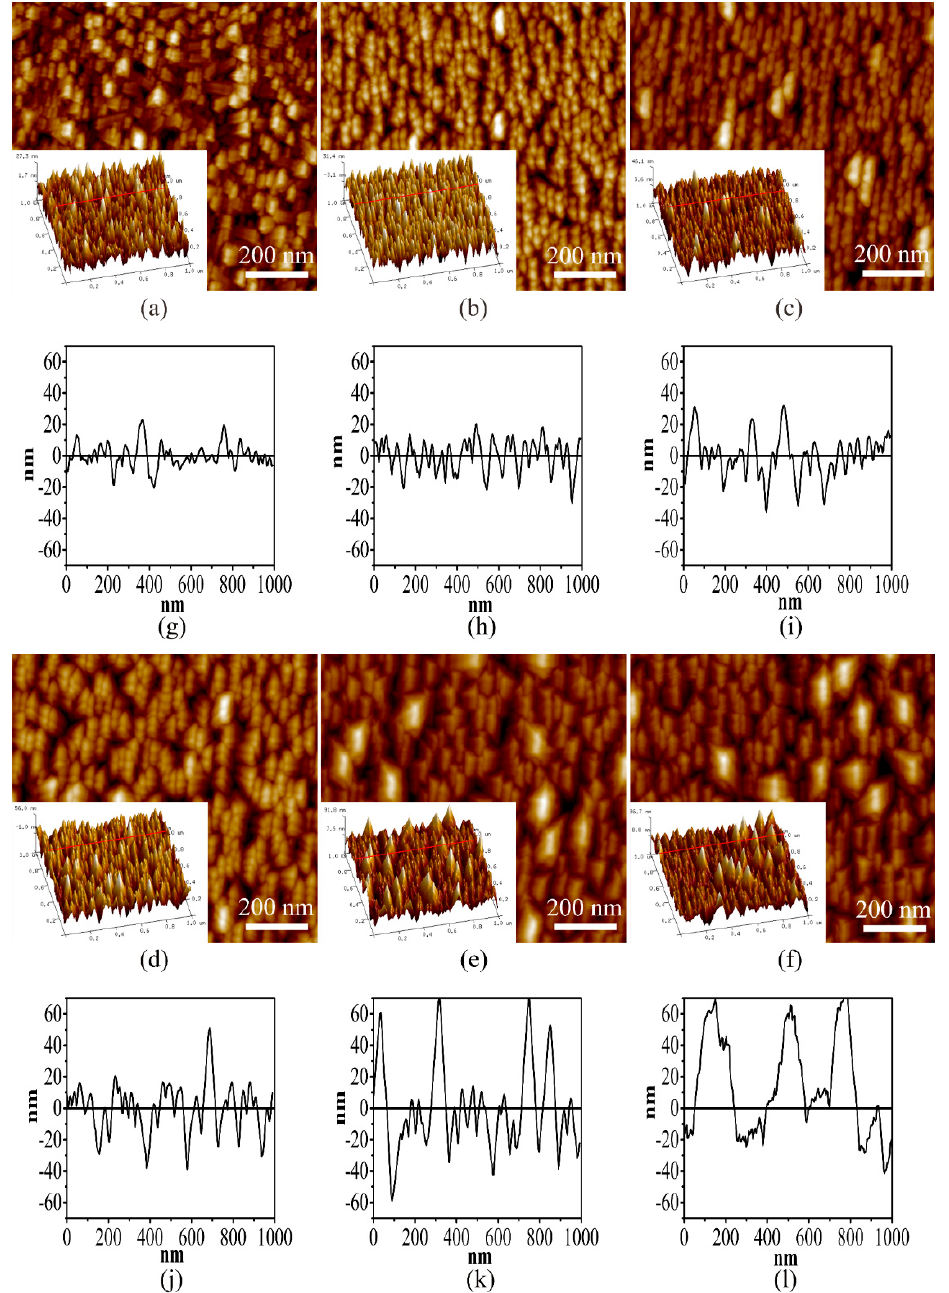
Figure 5. AFM micrographs of Fe films with different sputtering powers: ( a ) 160 W, ( b ) 230 W, ( c ) 260 W, ( d ) 283 W, ( e ) 360 W, ( f ) 420 W; respective sectional height contour: ( g ) 160 W, ( h ) 230 W, ( i ) 260 W, ( j ) 283 W, ( k ) 360 W, ( l ) 420 W.